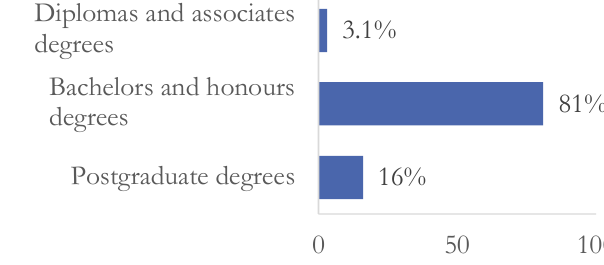
Figure 10. Qualifications required in Australian blockchain- related job ads between August 2017 and August 2018.